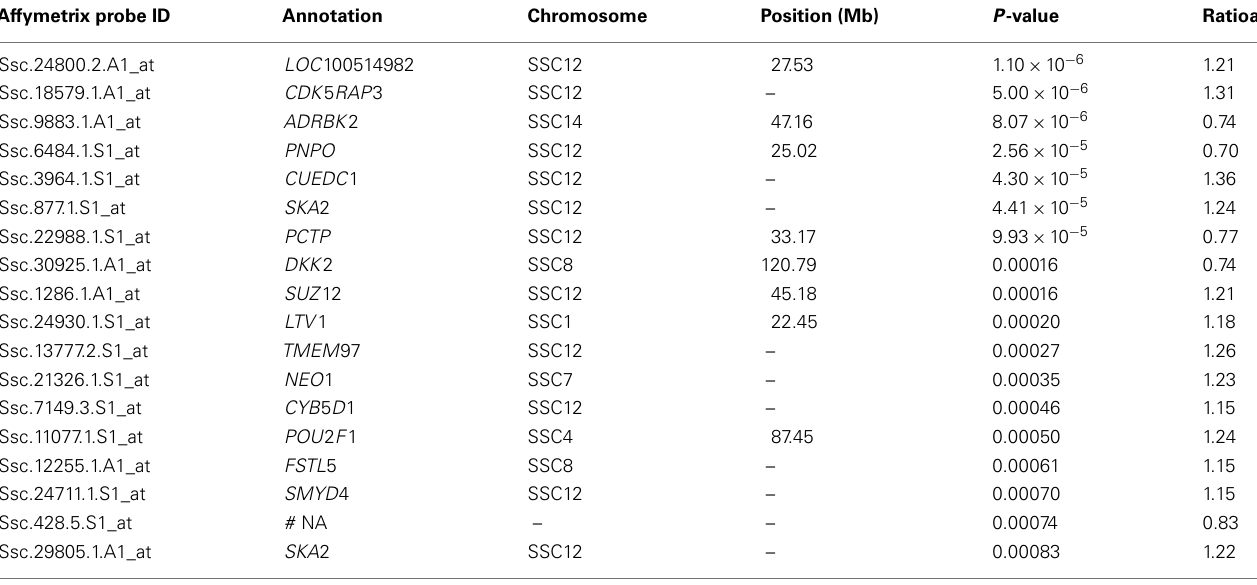
TableA6 | Differentially expressed probes between Qq and qq QTL genotypes with effect on C16:0. Affymetrix probe ID